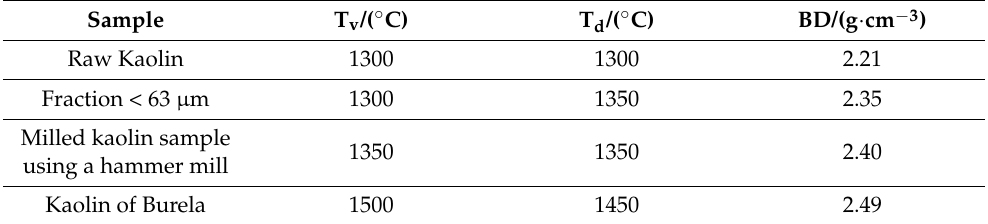
Table 4. Experimental results of estimated vitrification temperature T v ( ◦ C), temperature of the maximum apparent density T d ( ◦ C) and values of maximum bulk density, BD (g cm − 3 ), of raw kaolin and fraction < 63 µ m studied in this work, compared to Kaolin of Burela, determined from range curves (see the text) under the same conditions.